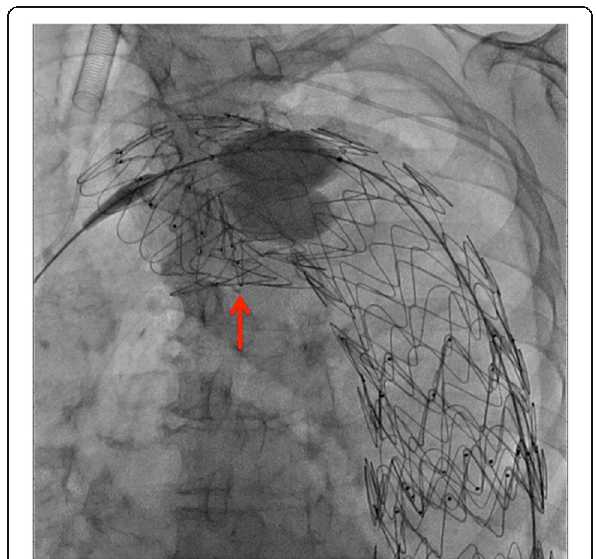
Fig. 1 Fluoroscopic image immediately after additional stent grafting. The inner curved side of the proximal portion of the additional SG stopped perpendicular to the vascular wall (red arrow) and failed to deploy